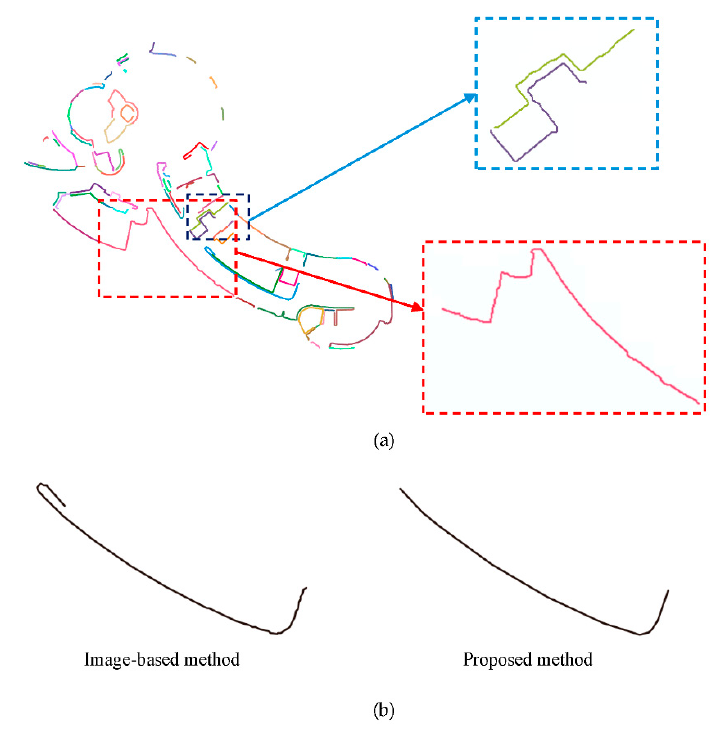
Figure 16. Curve detection result using image-based method. ( a ) The image-based method can’t distinct the straight parts and curved parts well; ( b ) the detected curves are not as smooth as proposed method.